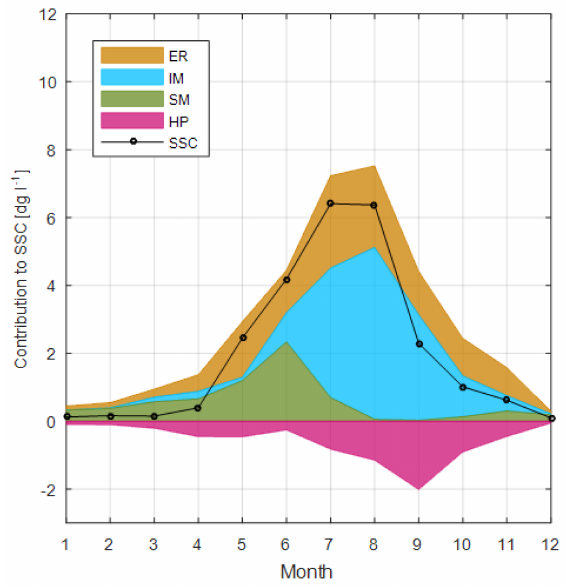
Figure 6. Mean monthly values of SSC t computed with HMRC (black line with circles). Coloured areas represent the mean monthly contribution to SSC t of ER t − 1 , IM t − 1 , SM t − 1 , and HP t (dilution) averaged over the observation